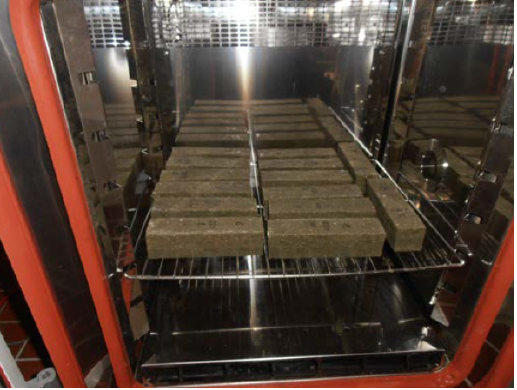
Figure 3. Specimens in the climatic chamber.